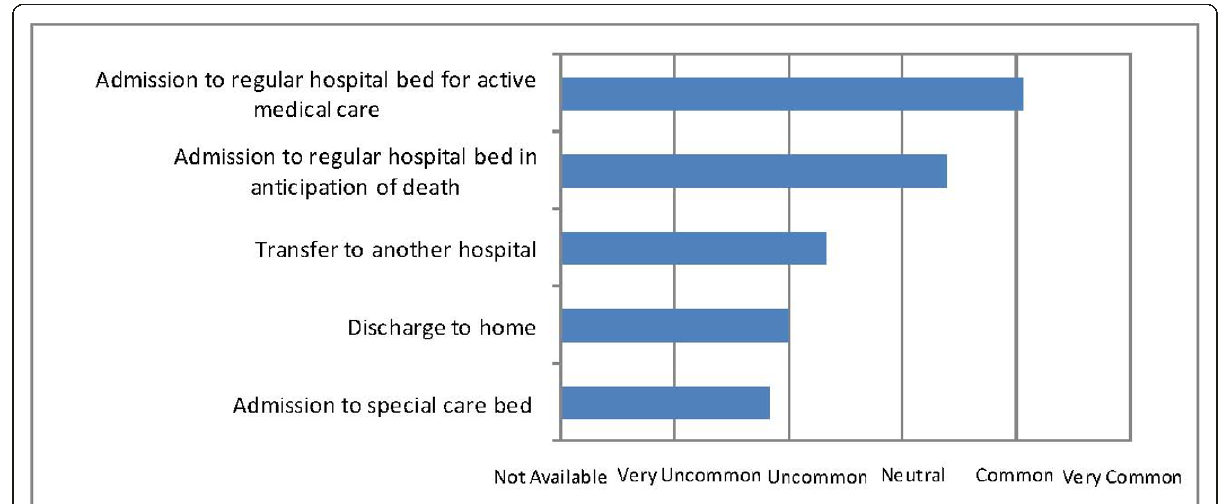
Figure 2 Likelihood of treatment plan for a critically ill patient .